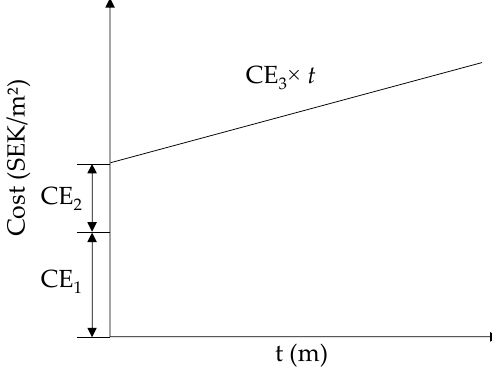
Figure 4. Cost function for insulation of the building envelope.